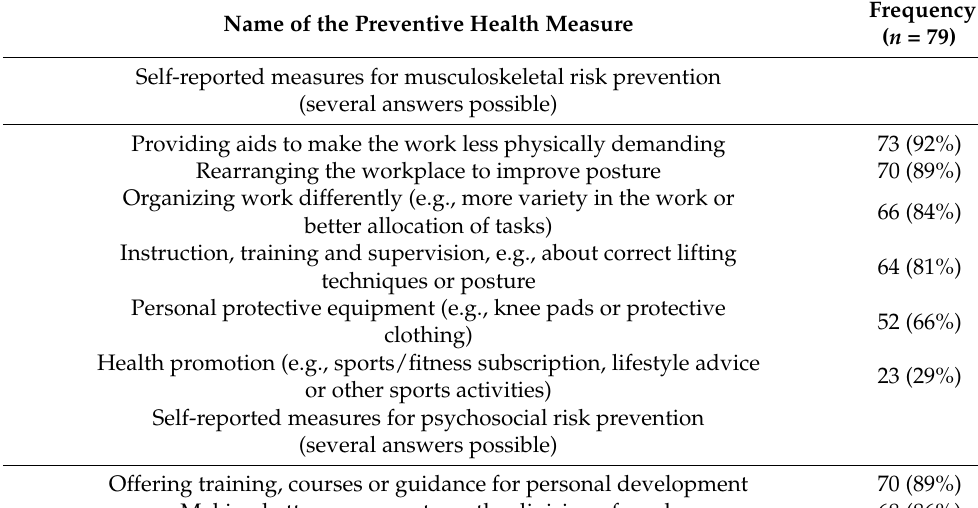
Table 2. Use of preventive health